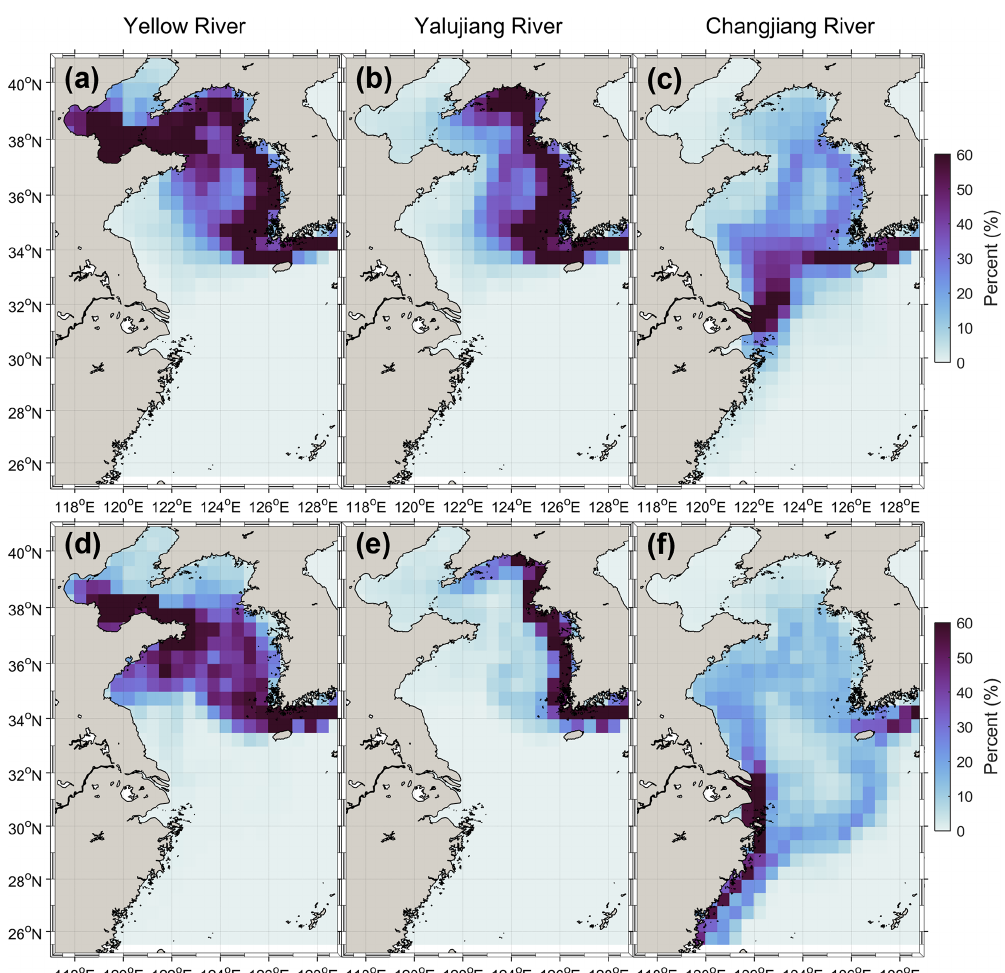
Figure 7. The annually averaged water transport pathways of the three rivers over the shelf for the tidal–advection case (a–c) and tidal–mixing case (d–f) , indicated by the emergence probability of the particles in the grids (in